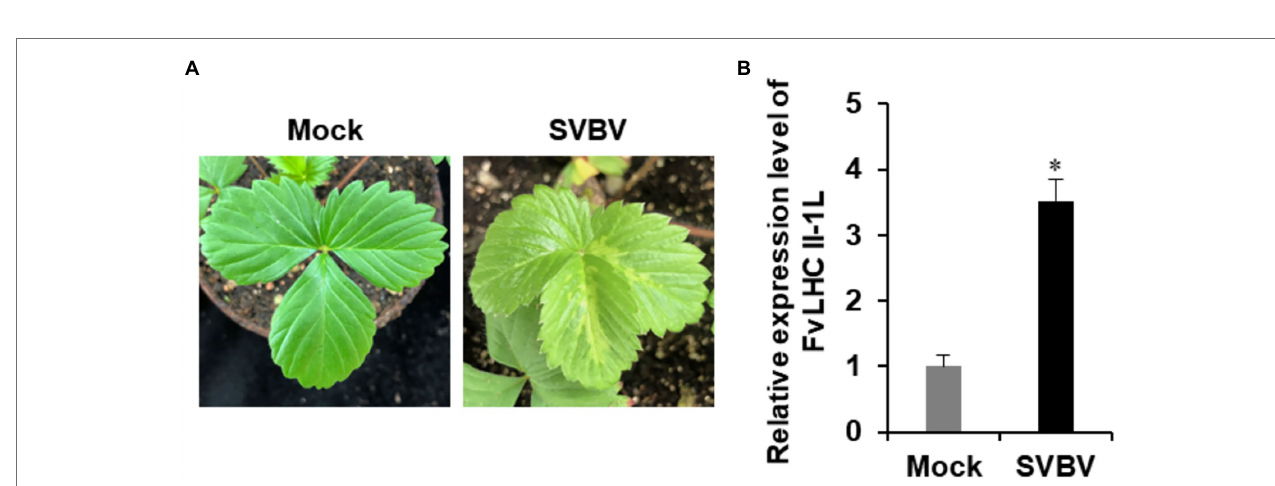
FIGURE 3 | Expression of FvLHC II-1L is upregulated by SVBV in infected F. vesca . (A) Phenotype of mock-inoculated or SVBV-inoculated F. vesca . (B) The transcript levels of FvLHC II-1L in mock-inoculated and SVBV-infected leaves of F. vesca were determined using quantitative real-time polymerase chain reaction (RT-qPCR) analysis. Error bars indicate the mean ± standard deviation of three replicates. A two-sample unequal variance directional t -test was used to test the significance of the difference (* p <